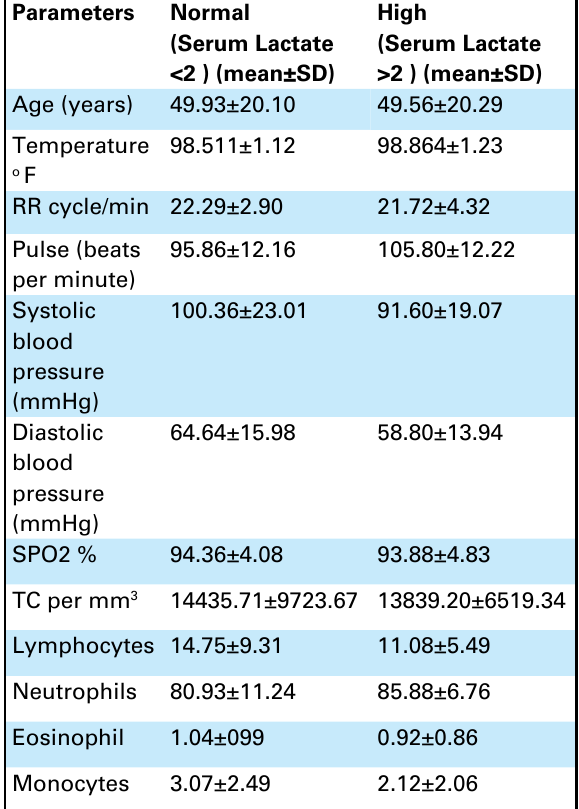
Table 2. Descriptive statistics of patients diagnosed with sepsis.